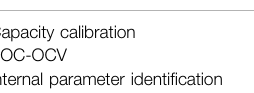
TABLE 1 | Test matrix of RPT. Test items Test protocol